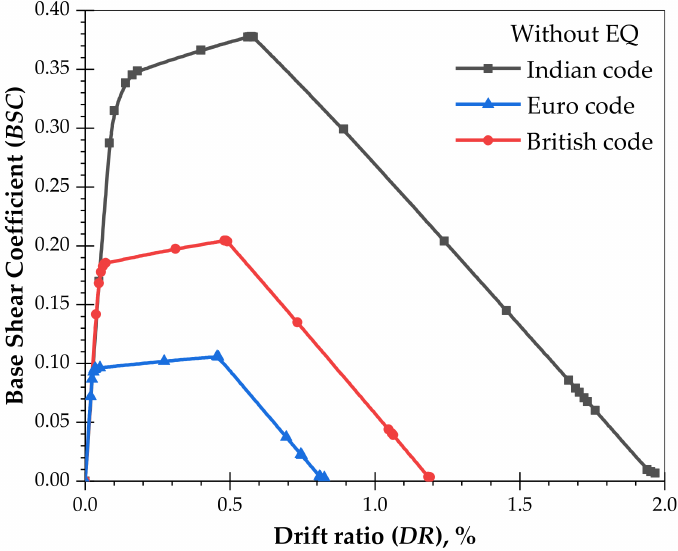
Figure 5. Base Shear Coe ffi cient versus Drift Ratio for without earthquake (WoEQ)